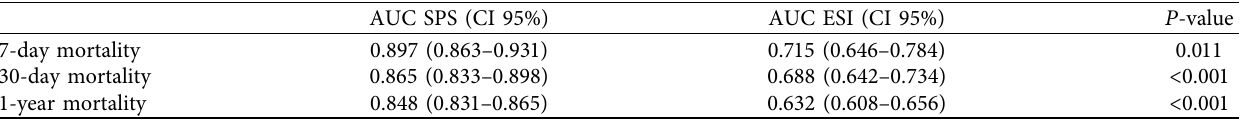
Table 4: Comparison of the AUROC of SPS and ESI. Comparison of the area under the curve of the receiving operating characteristics of the Simple Prognostic Score and Emergency Severity Index.